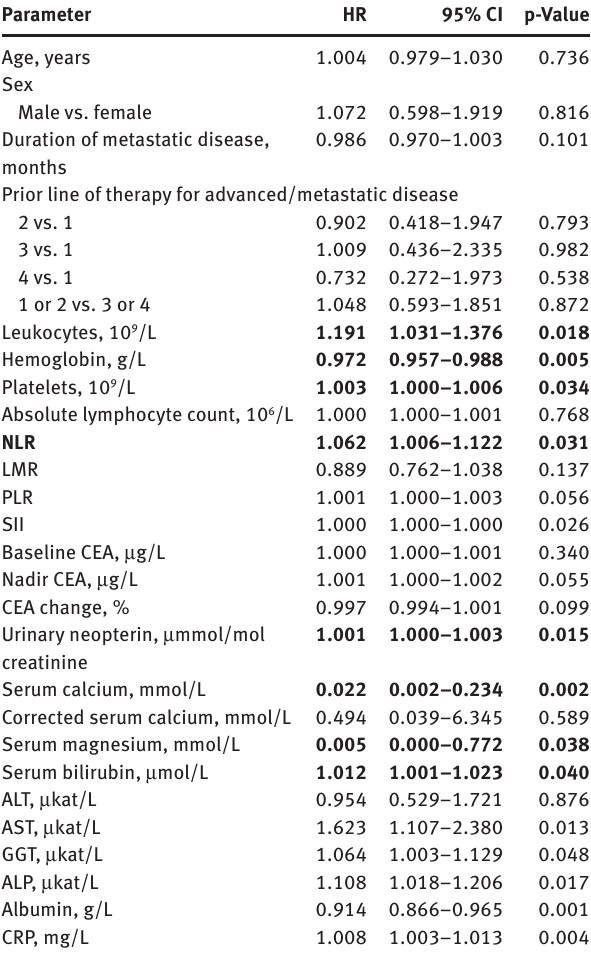
Table 4: Univariate analysis of the prognostic significance of clinical and laboratory parameters.